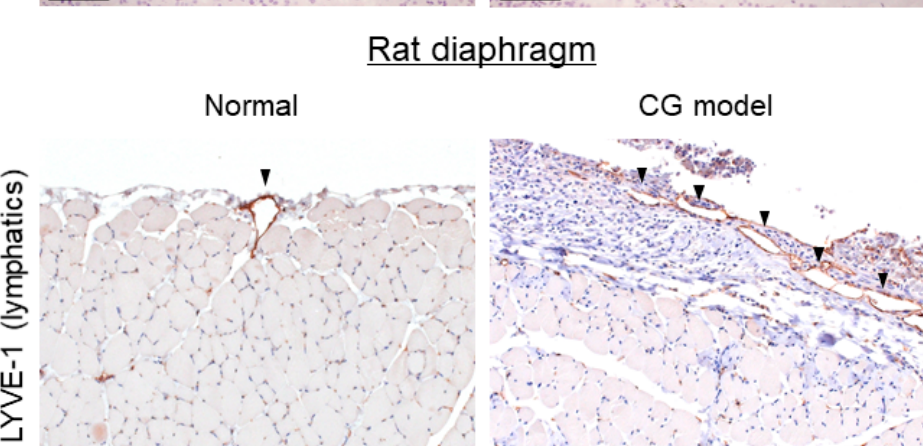
Figure 2. Lymphangiogenesis occurs in renal and peritoneal fibrosis. Lymphangiogenesis was observed in a human diabetic nephropathy case and in a rat diaphragmatic fibrosis model induced by chlorhexidine gluconate (CG) by immunohistochemistry. D2-40 and lymphatic vessel endothelial hyaluronan receptor-1 (LYVE-1) are lymphatic markers. Arrowheads indicate lymphatic vessels. Scale bars = 100 μ m.